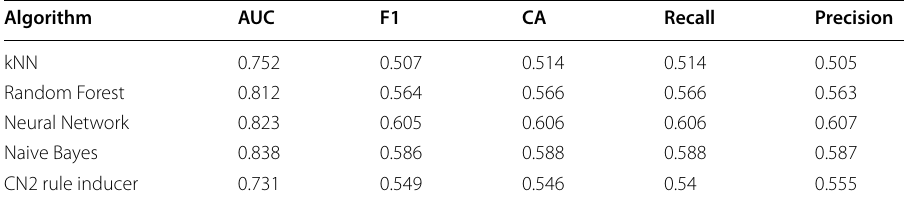
Table 16 Comparative evaluation of the performance of the data mining algorithms using Orange software